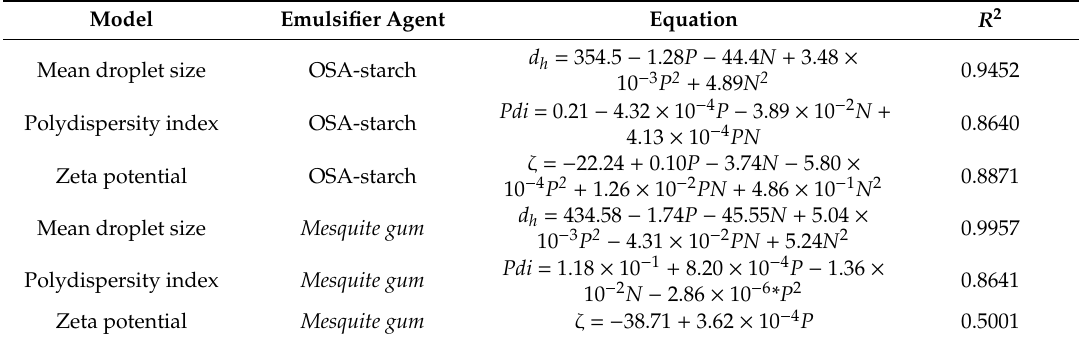
Table 2. Optimal models predicted by the surface response methodology for green coffee oil emulsions.